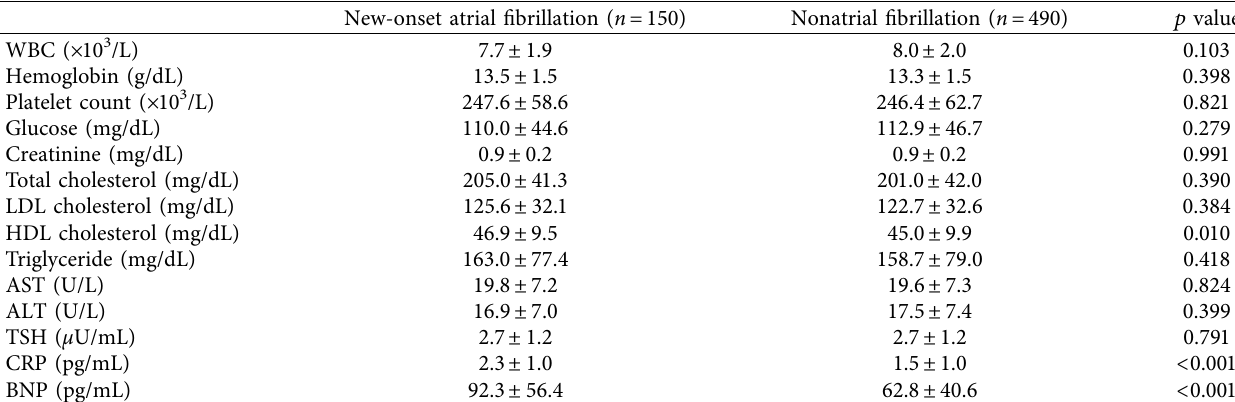
Table 3: Laboratory